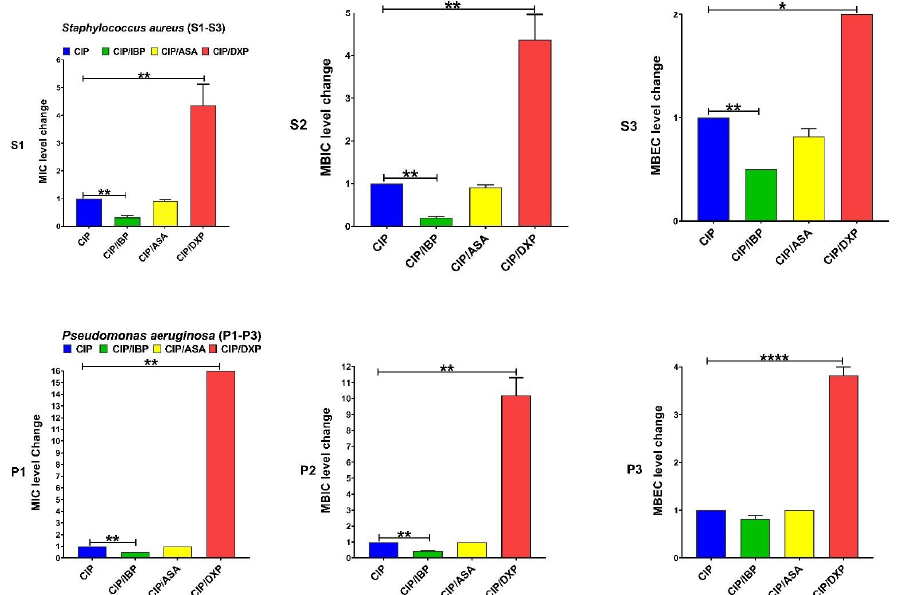
Figure 1. Effects of sub-MICs of ibuprofen (IBP: 200 µ g/mL), aspirin (ASA: 200 µ g/mL), and dexamethasone sodium phosphate (DXP: 500 µ g/mL) on the levels of MIC, MBIC, and MBEC of ciprofloxacin (CIP) for clinical isolates. Graphs were drawn based on fold changes of MIC, MBIC, and MBEC of CIP in combination with sub-MICs of IBP, ASA, and DXP on clinical isolates. Data are displayed as the mean ± standard error of the mean from 3 replicate experiments and were analyzed using ANOVA and nonparametric Kruskal–Wallis test. See S1–S3 for S. aureus isolates and P1–P3 for P. aeruginosa isolates. IBP significantly decreased the level of MIC and MBIC for CIP among both clinical isolates and MBEC among MRSA. ASA had no significant effects on the level of MIC, MBIC, and MBEC for CIP, and DXP significantly increased the level of MIC, MBIC, and MBEC for CIP among both clinical isolates. *, statistical significance with p ≤ 0.05; **, statistical significance with p ≤ 0.01; and ****, statistical significance with p ≤ 0.0001.